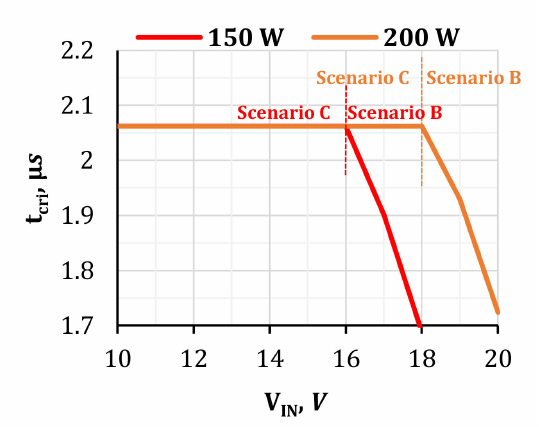
Figure 8. Dependence of t cri on the input voltage at various power levels for scenarios B and C.